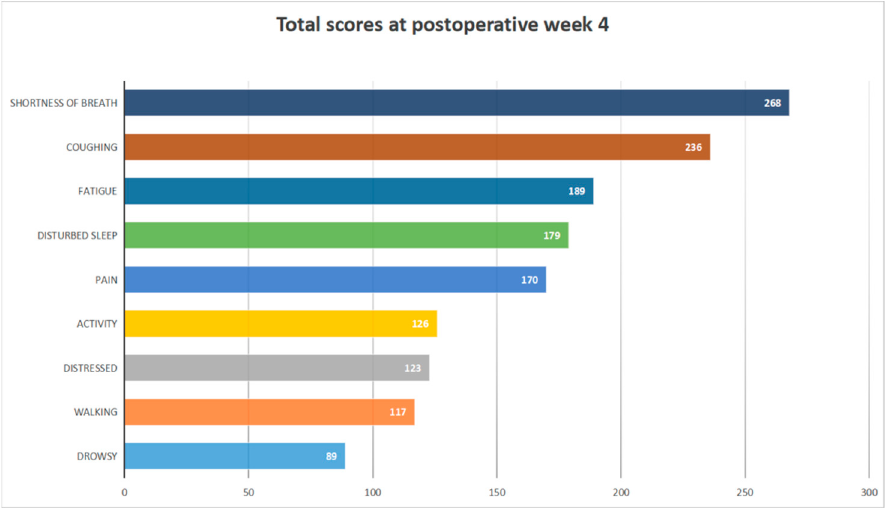
Figure 2. Total scores at postoperative week